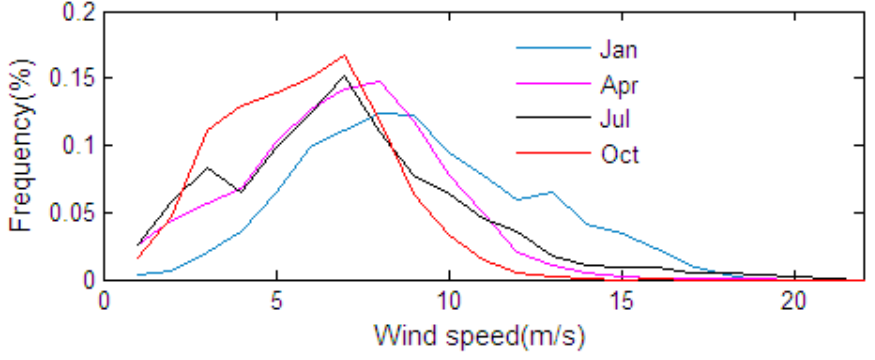
Figure 3. Wind speed distribution in different seasons.